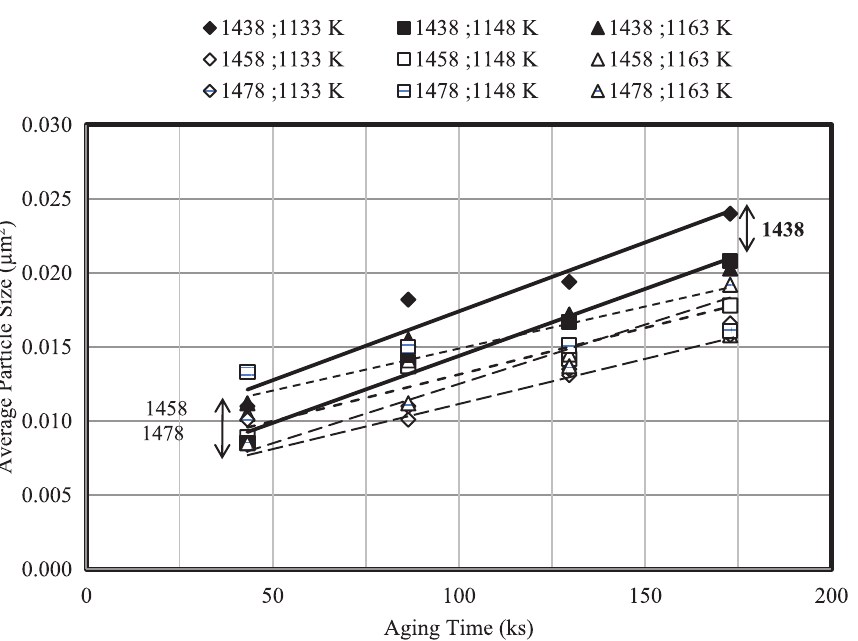
Fig. 6: Average particle size of γ ′ particles at various aging times of each aging temperature after solutionizing temperatures of 1,438, 1,458 and 1,478 K for 14.4